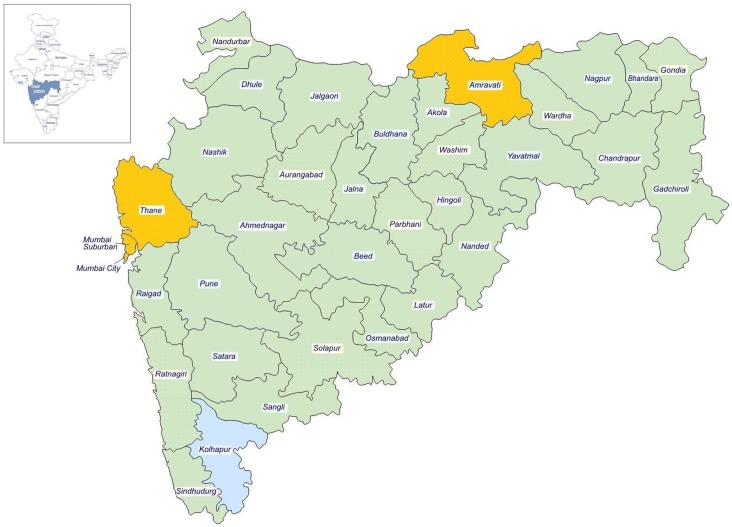
Data collection sites for the study in Maharashtra, India (2013–15): Mumbai, Thane & Palghar and Amaravati.